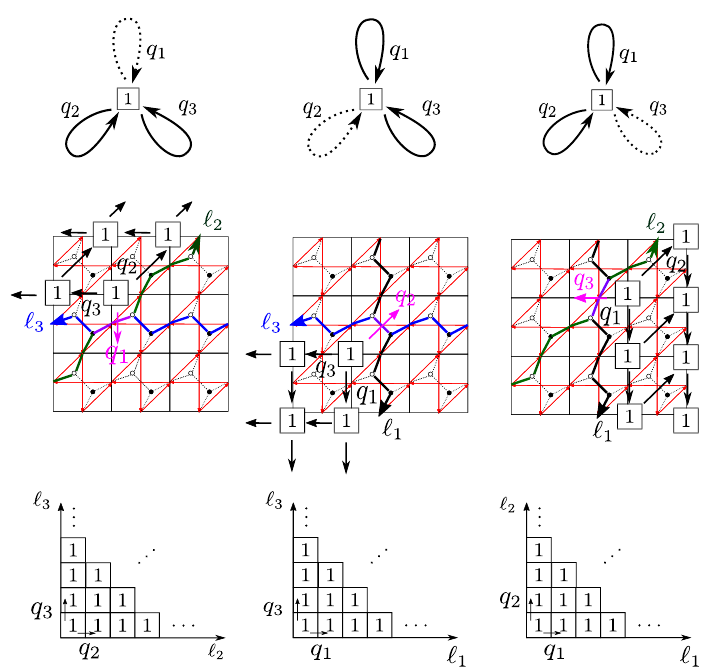
Figure 25. Subquivers and two-dimensional crystals of C 3 . Left: crystal of divisor p 1 = (0 , 1) . arrow removed is m = { q . The crystal is the region surrounded by external legs ‘ and ‘ , 1 1 } 2 3 which means it is a Young diagram with two coordinates q and q . The nontrivial central charge 2 3 is q 1 / 2 . Middle: crystal of divisor p = (0 , 0) . arrow removed is m = { q . The crystal is the 2 2 2 } 1 region surrounded by zig-zag paths of external legs ‘ , which means a Young diagram with 1 , ‘ 3 coordinates q . The central charge is q 1 / 2 . Right: crystal of divisor p = (1 , 0) . arrow removed 1 , q 3 3 2 is m = { q . The crystal shape is the region surrounded by ‘ and ‘ , which is a Young diagram 3 3 } 1 2 with two coordinates q . The central charge is q 1 / 2 1 , q 2 3